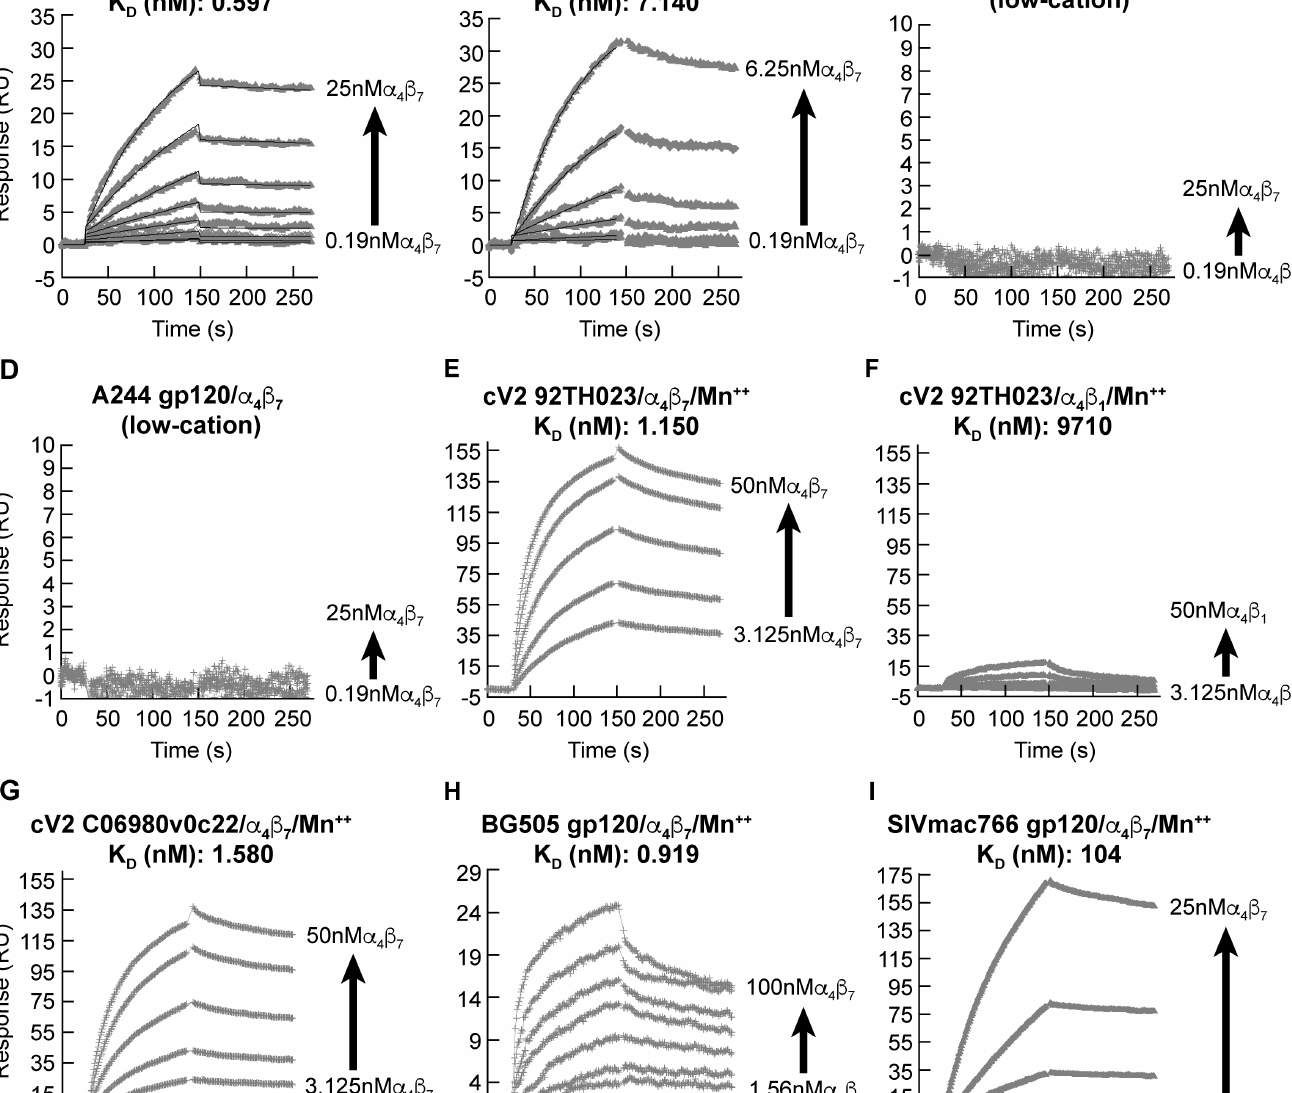
PLOS Pathogens| https://doi.org/10.1371/journal.ppat.1007278 August 28,